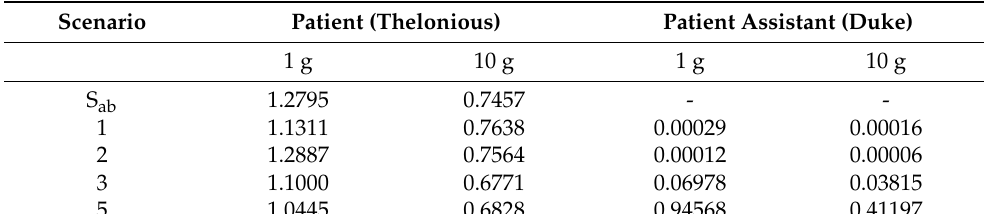
Table 5. Peak spatially averaged SAR (W/kg) in Thelonious (patient) and Duke (patient assistant) according to RF body coil (input power = 1 W).